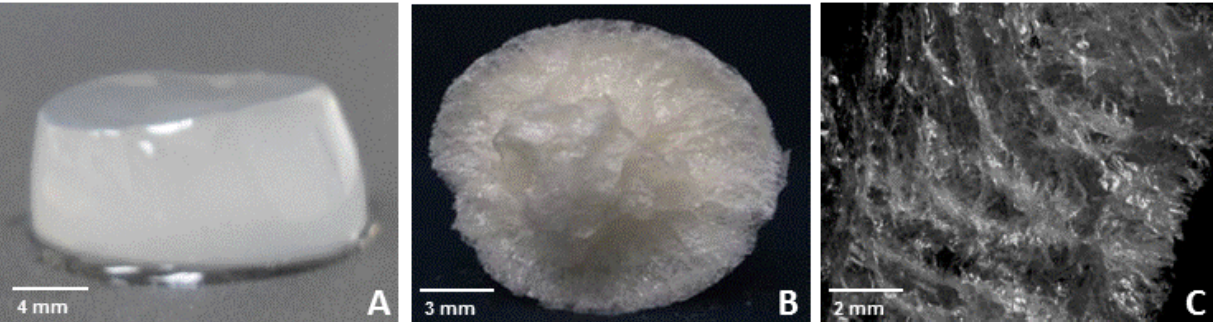
Figure 5. WEAX gel ( A ), lyophilized WEAX gel ( B ), stereomicrograph of lyophilized WEAX gel ( C ) and SEM micrographs of lyophilized WEAX gel at 35× magnification ( D ), 200× magnification ( E ) and 350× magnification ( F